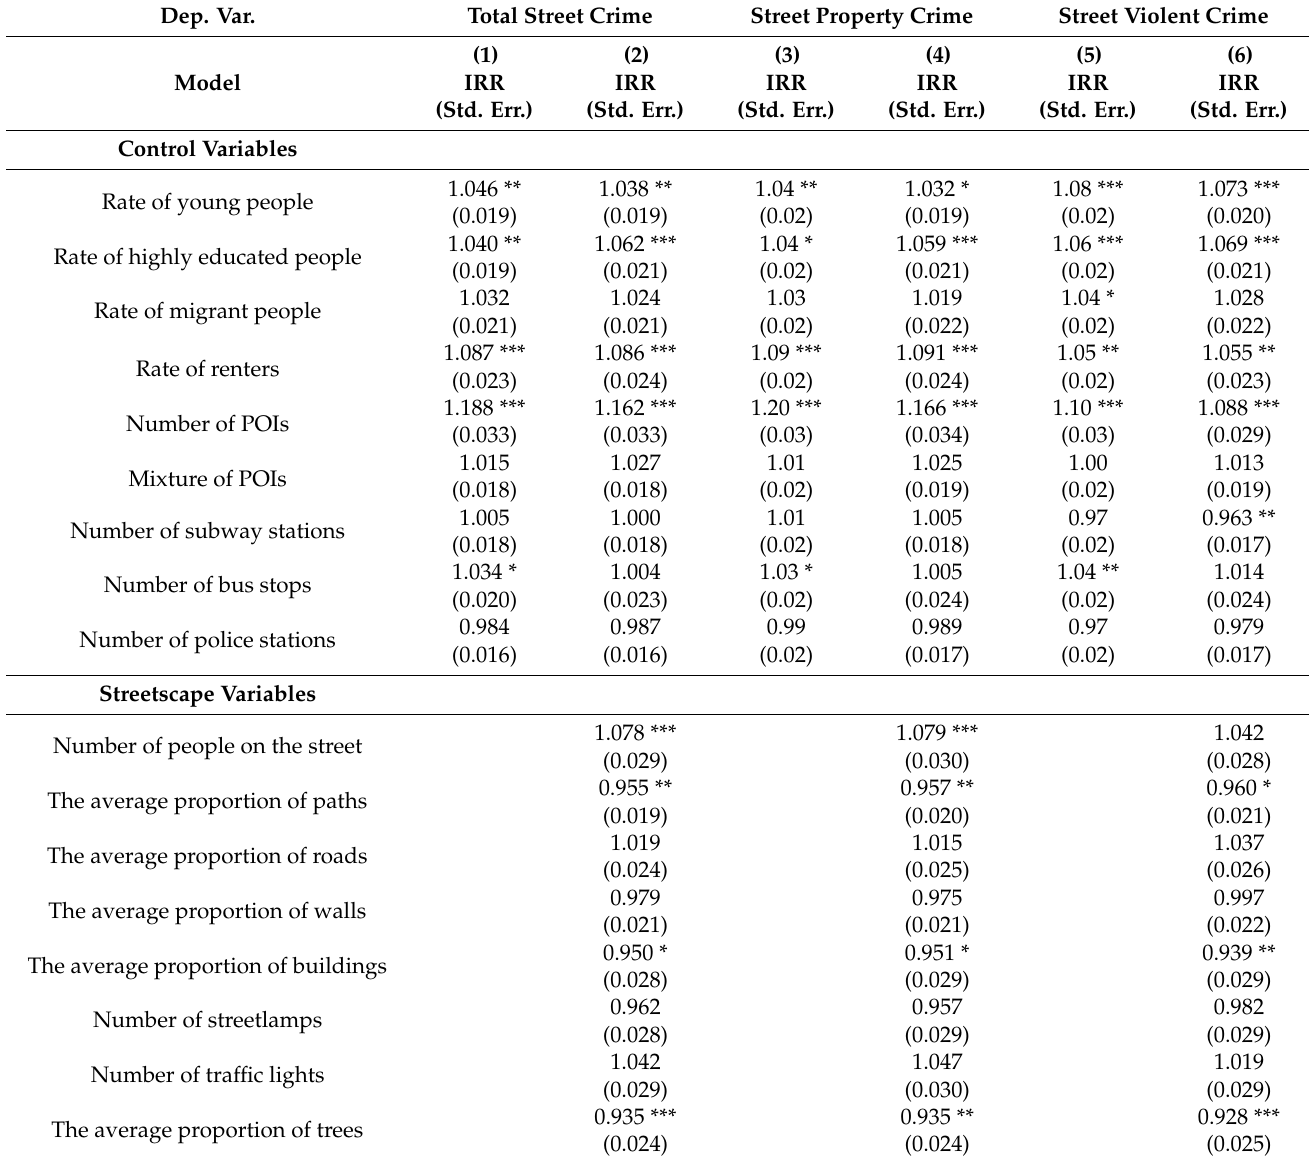
Table 2 presents the results of the spatial lag negative binomial regression estimations. Models (1, 3, and 5) are baseline models which only included the control variables, while Models (2, 4, and 6) are the full models which contained additional streetscape variables. Both the log-likelihood and AIC values demonstrated that adding street view variables improved the model fits. For total street crime, the log-likelihood of Model (2) ( − 3821.261) was larger than that of Model (1) ( − 3837.600), The AIC of Model (2) (7682.521) was smaller than that of Model (1) (7699.199). For street property crime, the log-likelihood of Model (4) ( − 3689.161) was larger than that of Model (3) ( − 3704.309), and the AIC of Model (4) (7418.322) was smaller than that of Model (3) (7432.617). For street violent crime, the log-likelihood of Model (6) ( − 2592.888) was larger than that of Model (5) ( − 2608.377), and the AIC of Model (6) (5225.775) was smaller than that of Model (5) (5240.753). Therefore, we discuss only the results of the full models in the following section. Table 2. Results of spatial lag negative binomial regression models with all independent variables